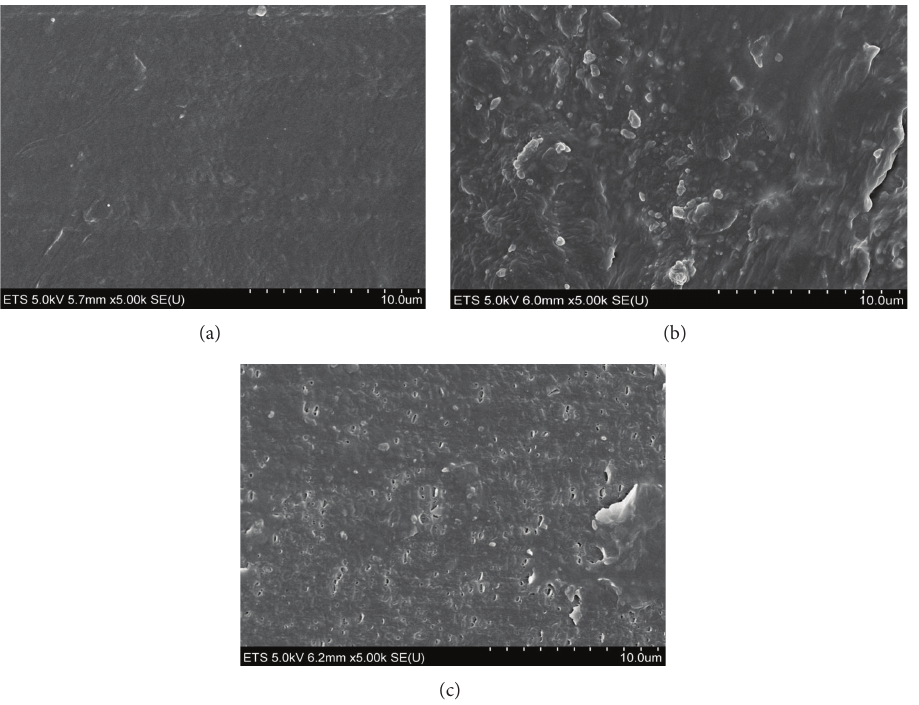
Figure 4: Representative SEM micrographs for (a) neat PE, (b) PE/O-MMT, and (c)